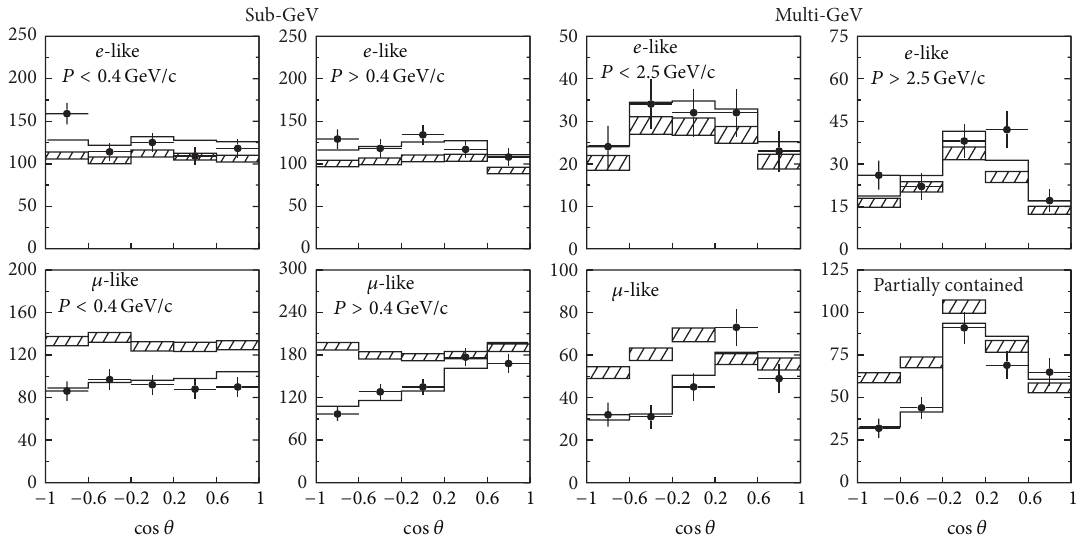
Figure 5: Zenith angle distributions of muon and electrons for sub-GeV and multi-GeV data from Super-Kamiokande [16]. The hatched regions are the Monte Carlo expectations for no-oscillations. The solid black lines plot the best fits for ] 𝜇 → ] 𝜏 oscillations; in the fit the overall flux normalization if left as a free parameter.